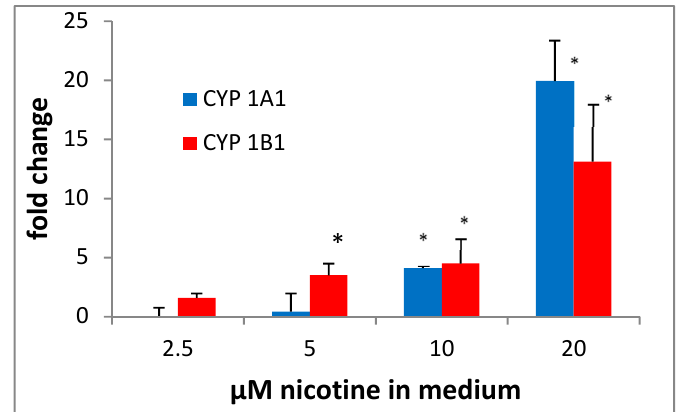
Figure 1. Effects of aerosol condensates (EACs) from blu and NJOY e-cigarettes, blu e-liquid, tobacco smoke extract (TSE), and α-napthoflavone on the metabolism of BaP to BaP-tetrols by MSK Leuk 1 cells. ( A ) Representative chromatograms of BaP tetrols. Cells were incubated for 18 h with or without additive and then for up to 16 h with 0.5 µ M BaP; 50 µ L of the filtered culture medium was applied to HPLC using conditions described in the Results and Discussion. The combined mass of the two standard BaP tetrols was 5 fmol. Traces (bottom to top), BaP tetrol I and II; tetrols generated from cells treated with BaP and: blu + α -NF (16 hr post BaP); blu (8 hr post-BaP); no additive (16 hr); blu (16 hr, post-BaP). ( B ) Dependence of the metabolism of BaP to BaP tetrols on the concentration of blu EAC. Concentrations of EAC are expressed as the concentration of nicotine they yield when added to the culture medium. The ordinate represents the concentration of BaP-tetrols generated in the culture medium. ( C ) E ff ects of EACs of blu, and NJOY, and TSE on the metabolism of BaP to BaP-tetrols. The concentration of nicotine in the medium was 5 uM for all of the EACs and e-liquid, and 2.5 uM for the TSE. The α -napthoflavone concentration was 10 uM. * p < 0.05 relative to the unpretreated control, using a two-tailed t-test.